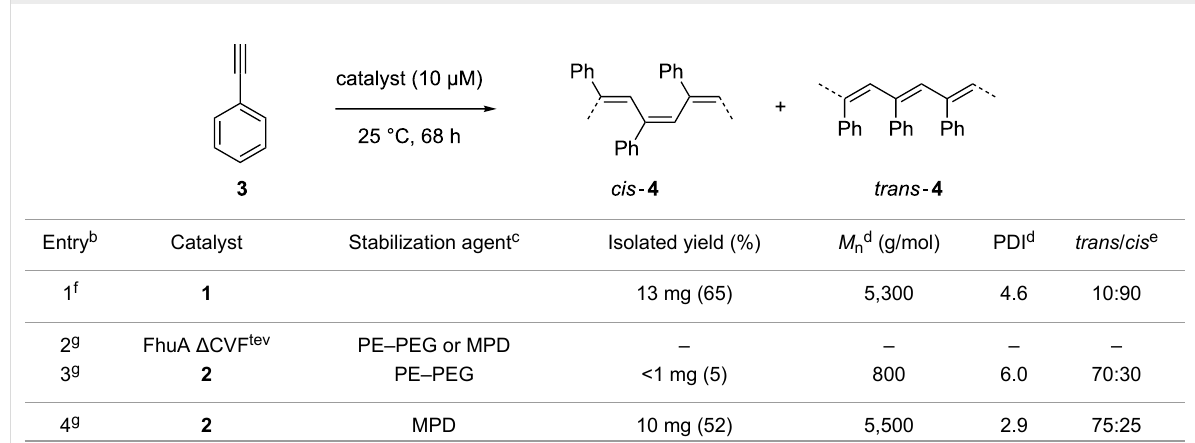
Table 2: Results of phenylacetylene ( 3 ) polymerization catalyzed by biohybrid conjugate 2 .